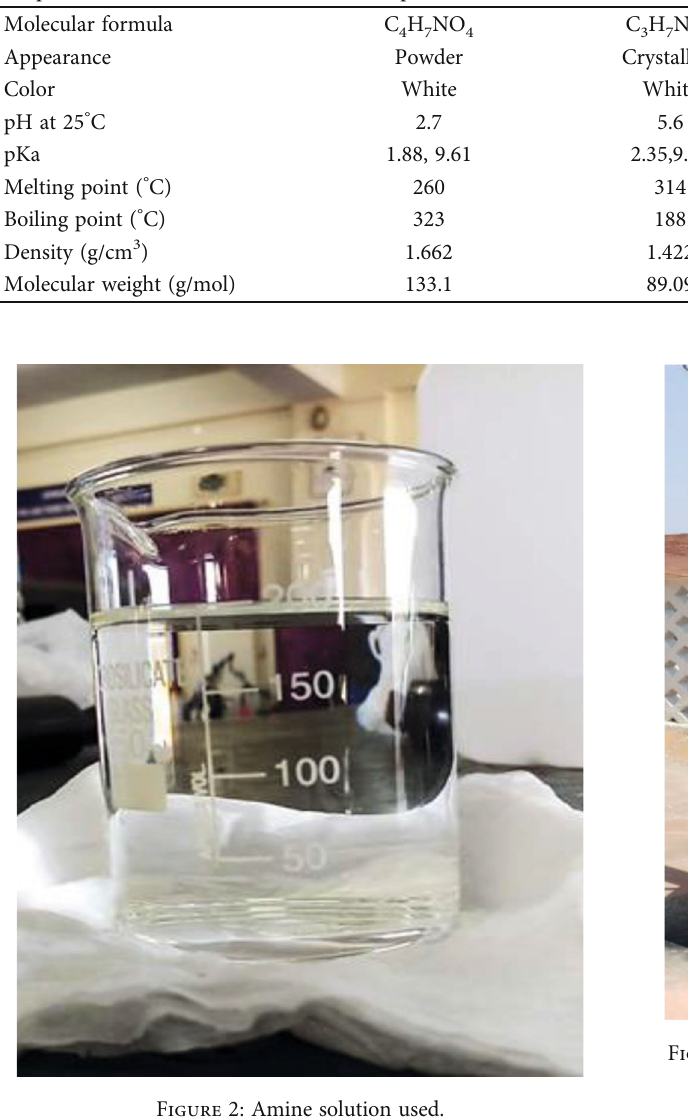
control system. 2